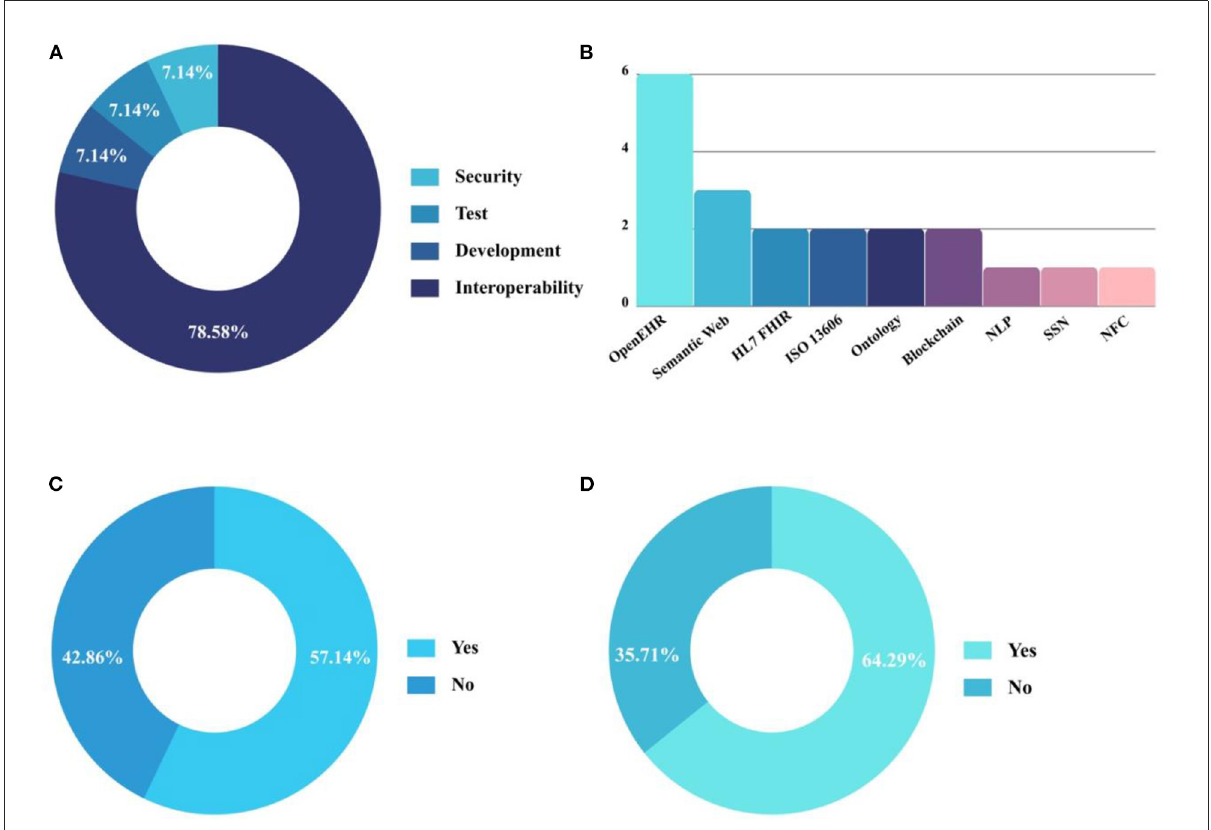
FIGURE2 Analysis of accepted articles after performing the systematic review protocol. (A) Approach discussed; (B) Standards and technologies used; (C) Percentage of EHR developed according to the Brazilian Ministry of Health; (D) Percentage of EHR developed using standards established by Brazilian